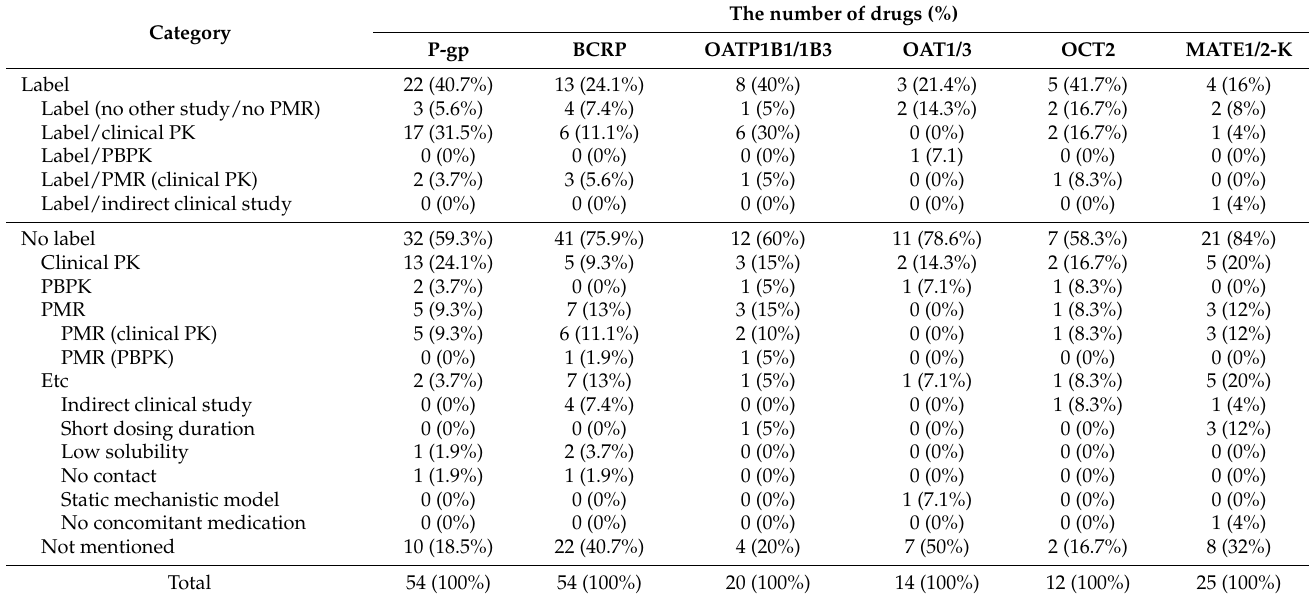
Table 3. Follow-up actions for in vitro transporter inhibitors with R values above the pre-defined cut-off